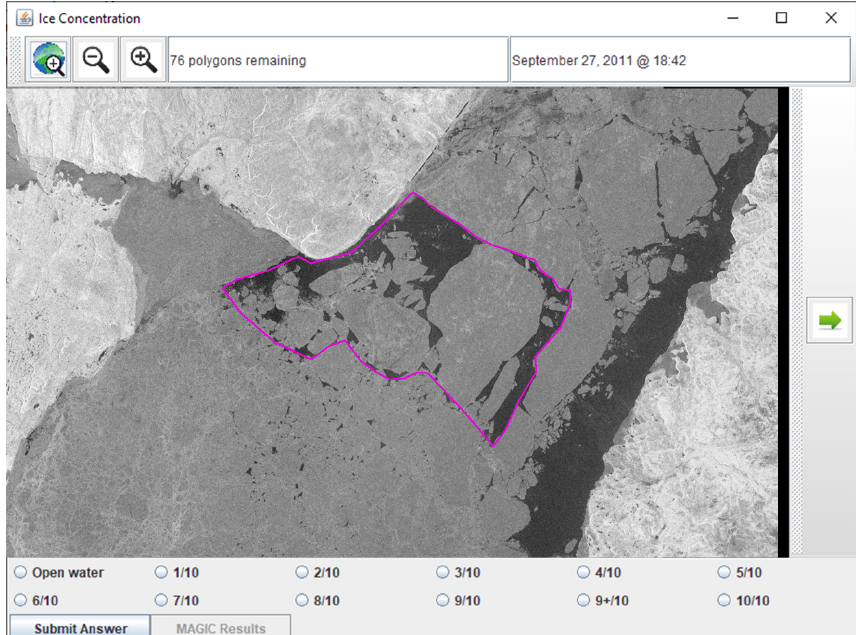
Figure 4. A screenshot of the user interface that the analysts were presented with. Each polygon was predefined so that all analysts estimated ice concentrations from the same polygons. The outlined polygon was presented to the analyst, who could zoom in and out and pan the image. They were then asked to input an ice concentration value. RADARSAT-2 Data and Products © MDA Geospatial Services Inc. (2012) – All Rights Reserved. RADARSAT is an official trademark of the Canadian Space Agency.